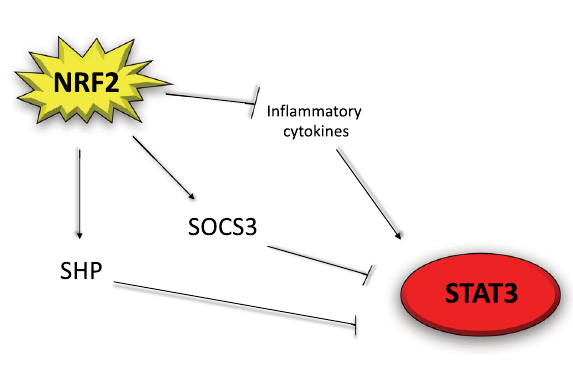
Fig. 2 Scheme illustrating the mechanisms through which NRF2 can inhibit